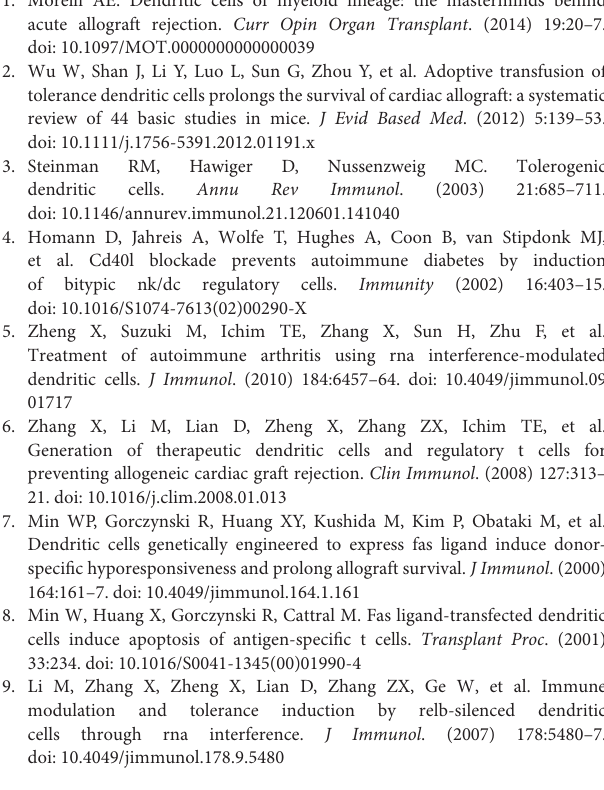
Supplemental Figure 2 | Treg generation. DCs were cultured from WT, GDF15 KO, and GDF15 Tg mice. These Cs cultured for 7 days were collected and co-cultured with allogeneic naïve T cells from BABL/c mice at the ratio of 1:10 for 5 days. CD4 + CD25 + FoxP3 + cells were detected by flow cytometry. Representative images were from n = 3 experiments. Supplemental Figure 3 | GDF15 TG DCs expressed lower levels of Phosphorylated p65. Phosphorylated p65 and beta-actin in DCs was detected by western blotting using phosphorylated p65A Abs and beta-actin Abs. Representative of image of western blotting (upper) and relative quantity of protein (low) from n = 3